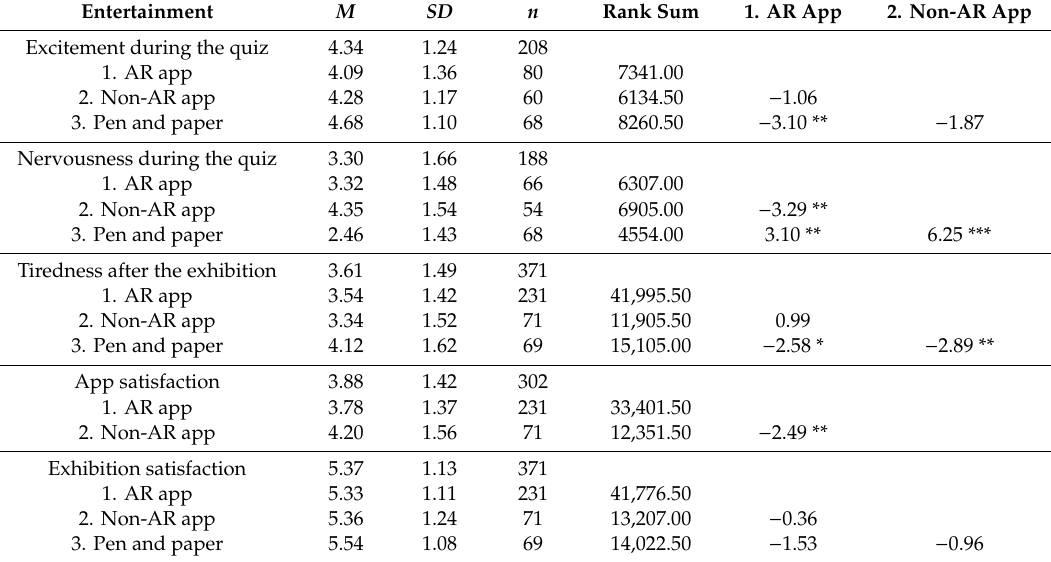
Table 4. Means ( M ), Standard Deviations ( SD ), Frequencies ( n ), Rank Sum, and Dunn’s Multiple Nonparametric Pairwise Post Hoc Test with Bonferroni Corrections for Di ff erences in Dependent Variables of Entertainment ( N =